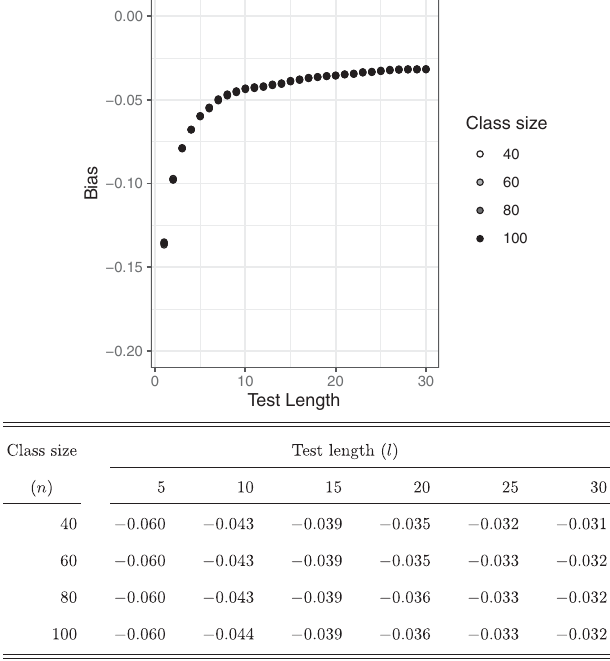
FIG. 5. The bias of Cohen ’ s d as a function of test length of the FCI-CAT, as calculated by Monte Carlo simulation [class size ¼ ð 40 ; 60 ; 80 ; 100 Þ , sample size ¼ 10 000 classes]. The true value of Cohen ’ s d is 0.38. The values in the table are characteristic points plotted in the graph.